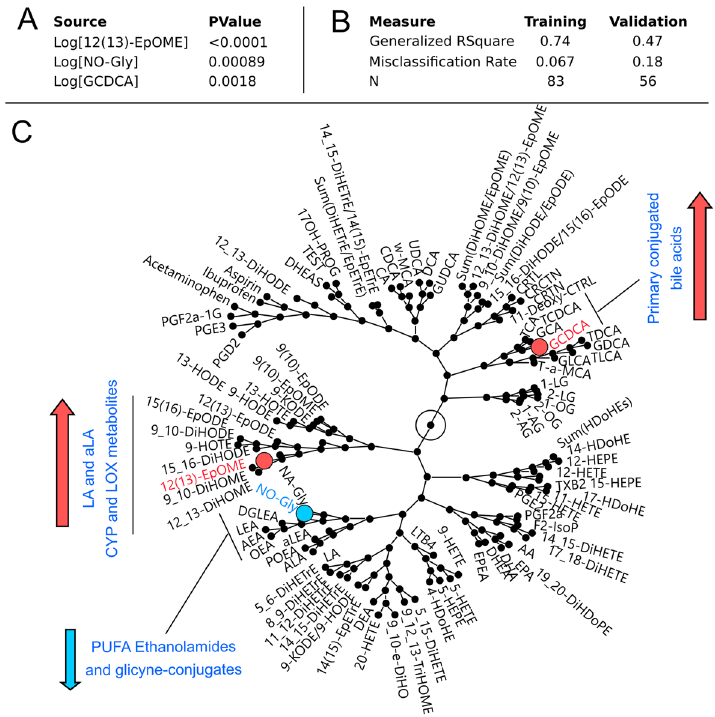
Figure 1. Serum lipid metabolites and bile acids are predictors of the fasting state. ( A ) Stepwise logistic model parameters predicting the fasting state using 12(13)-EpOME, GCDCA and NO-Gly. ( B ) Model statistics. ( C ) Visualization of the correlative environment (generated using hierarchical clustering) of metabolites used for fasting state prediction. Nodes represent branching points in the hierarchical clustering network with metabolites on the fringe named. Metabolite used in the final model are indicated by colors. Directionality of changes in metabolites due to non-fasted state compared to the fasted state are indicated by